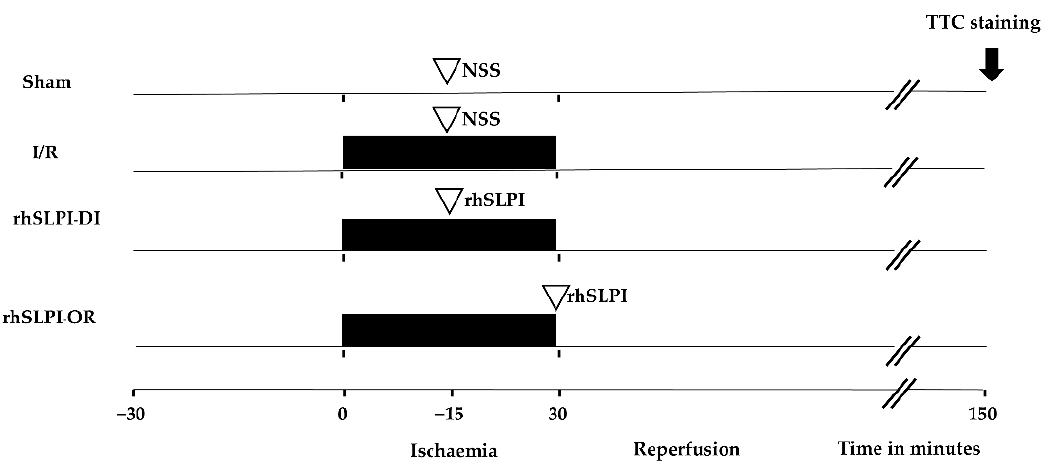
Figure 1. Schematic diagram of experimental protocol.